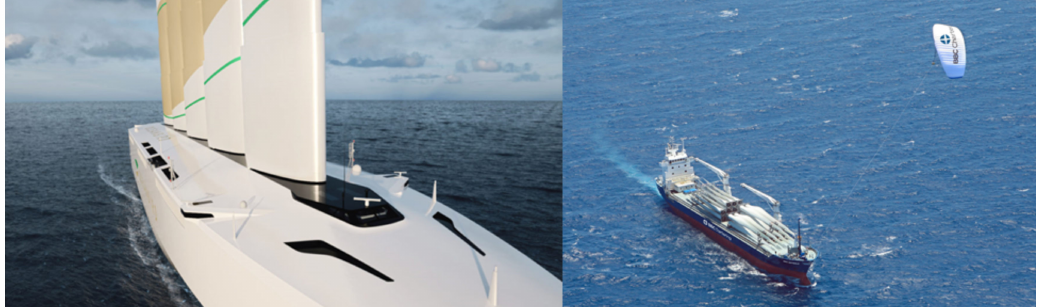
Figure 9. Oceanbird and Skysails as wind-powered solutions, Image Courtesy: Wallenius Marine and Skysails.